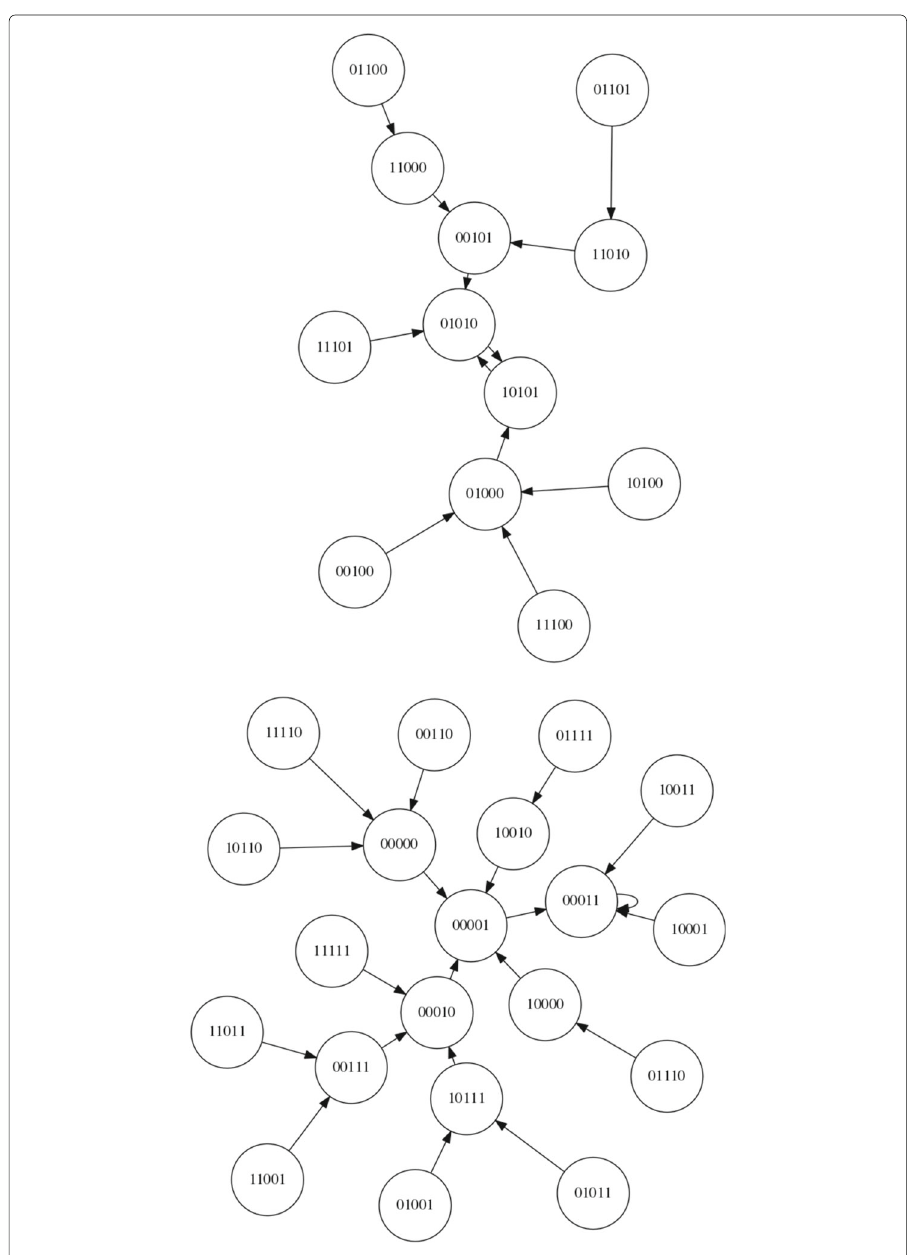
Fig. 8 NK Boolean network, instantiation 2 ( N = 5, K = 2)